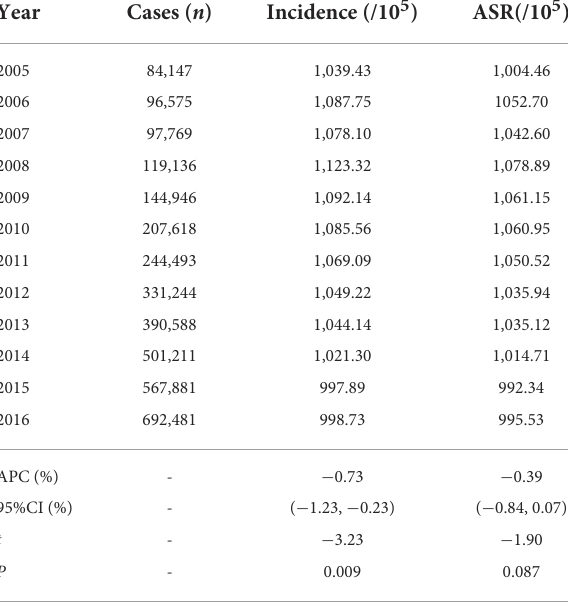
TABLE 1 Cancer incidence in Chinese older adults aged 60 and above from 2005 to